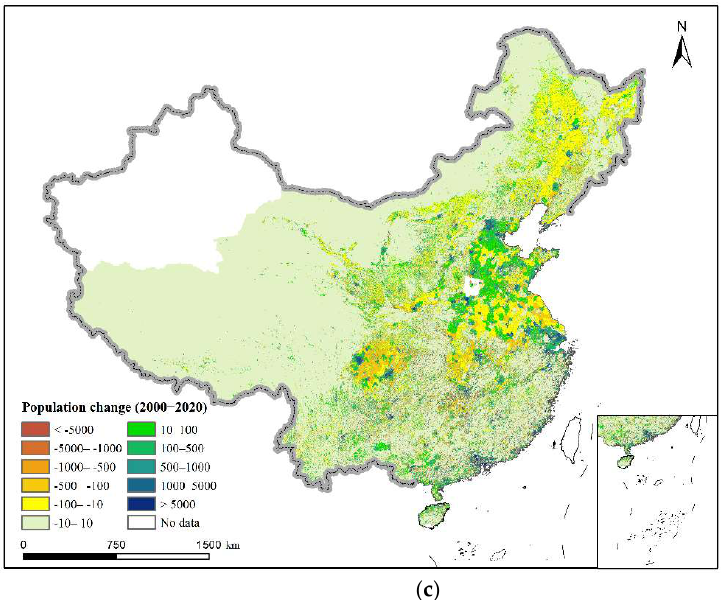
Figure 8. The spatial distribution of regional population changes in China for ( a ) 2000-2010, ( b ) 2010-2020, and ( c ) 2000-2020 .